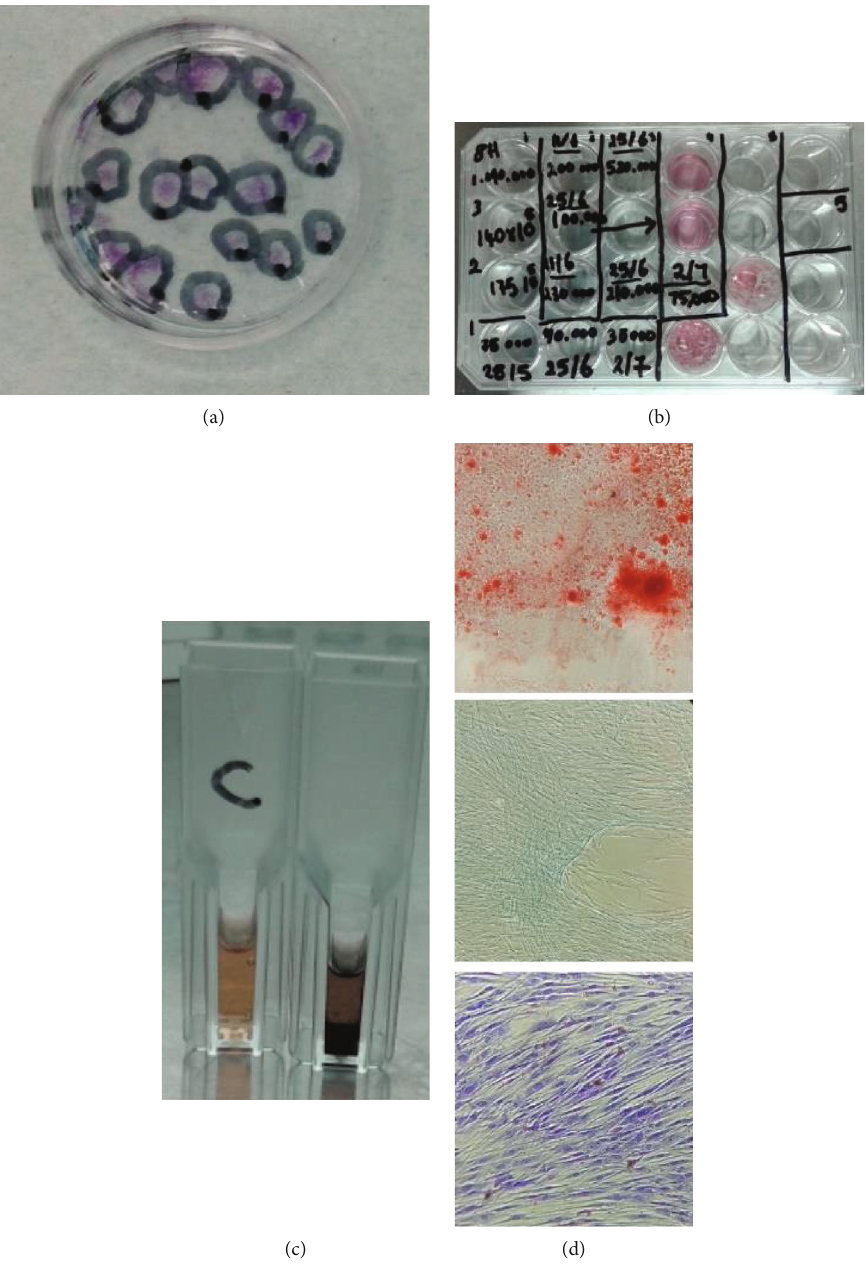
Figure 4: (a) Representative image of CFU experiment showing stem cell colony-forming potential. (b) Representative image showing the cell population doubling potential. (c) Representative image for the MTT essay showing black deposits in the experiment tube compared to the control group. (d) Representative image showing cell di ff erentiation potential; calcium deposition (upper), cartilage glycoprotein deposition (middle), and fat droplet deposition